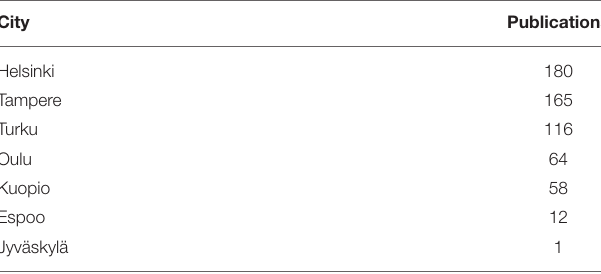
TABLE 1 | Number of published articles attributed to cities of Finland. City Publications